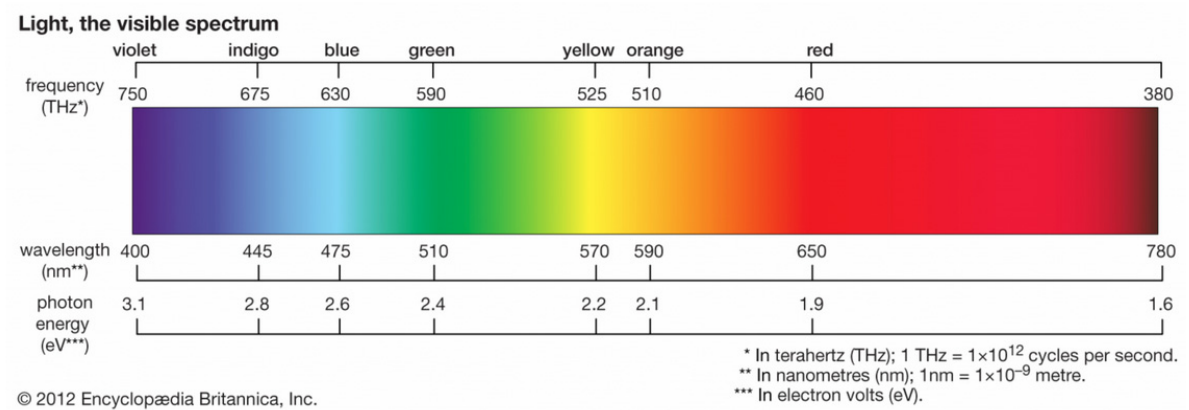
Figure 7. Light, the visible